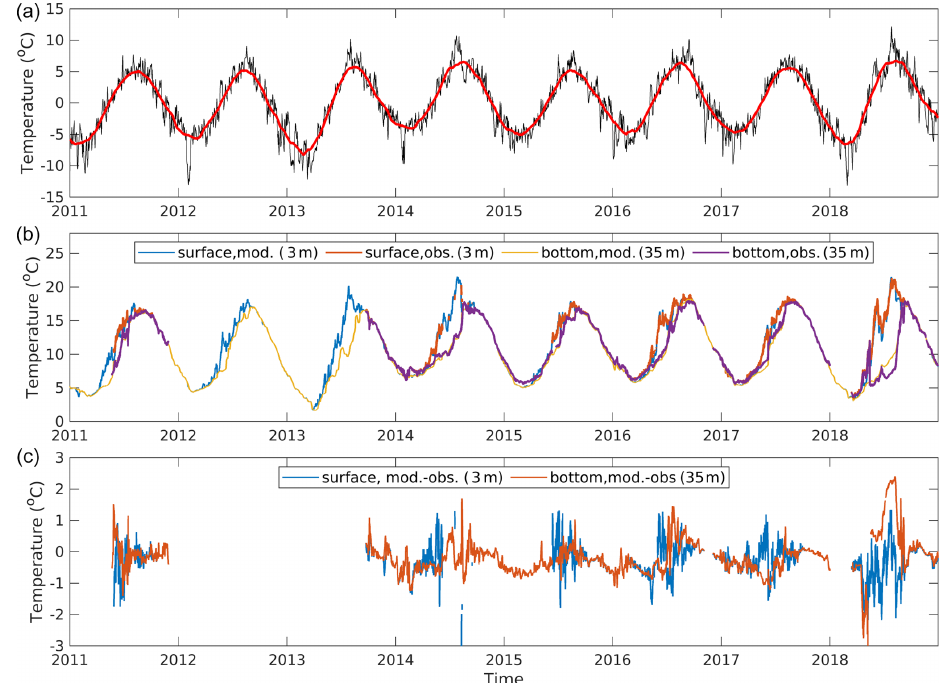
Figure 2. (a) Interannual variation in the air temperature (with the multiyear mean removed) at NSB III. The black line is the daily air temperature, and the thick red line represents the 3-month moving average. (b) The interannual variation in the observed (obs.) and simulated (mod.) water temperatures at the surface and the bottom of the same location. (c) Water temperature differences between the model and the in situ measurements at the surface and the bottom.